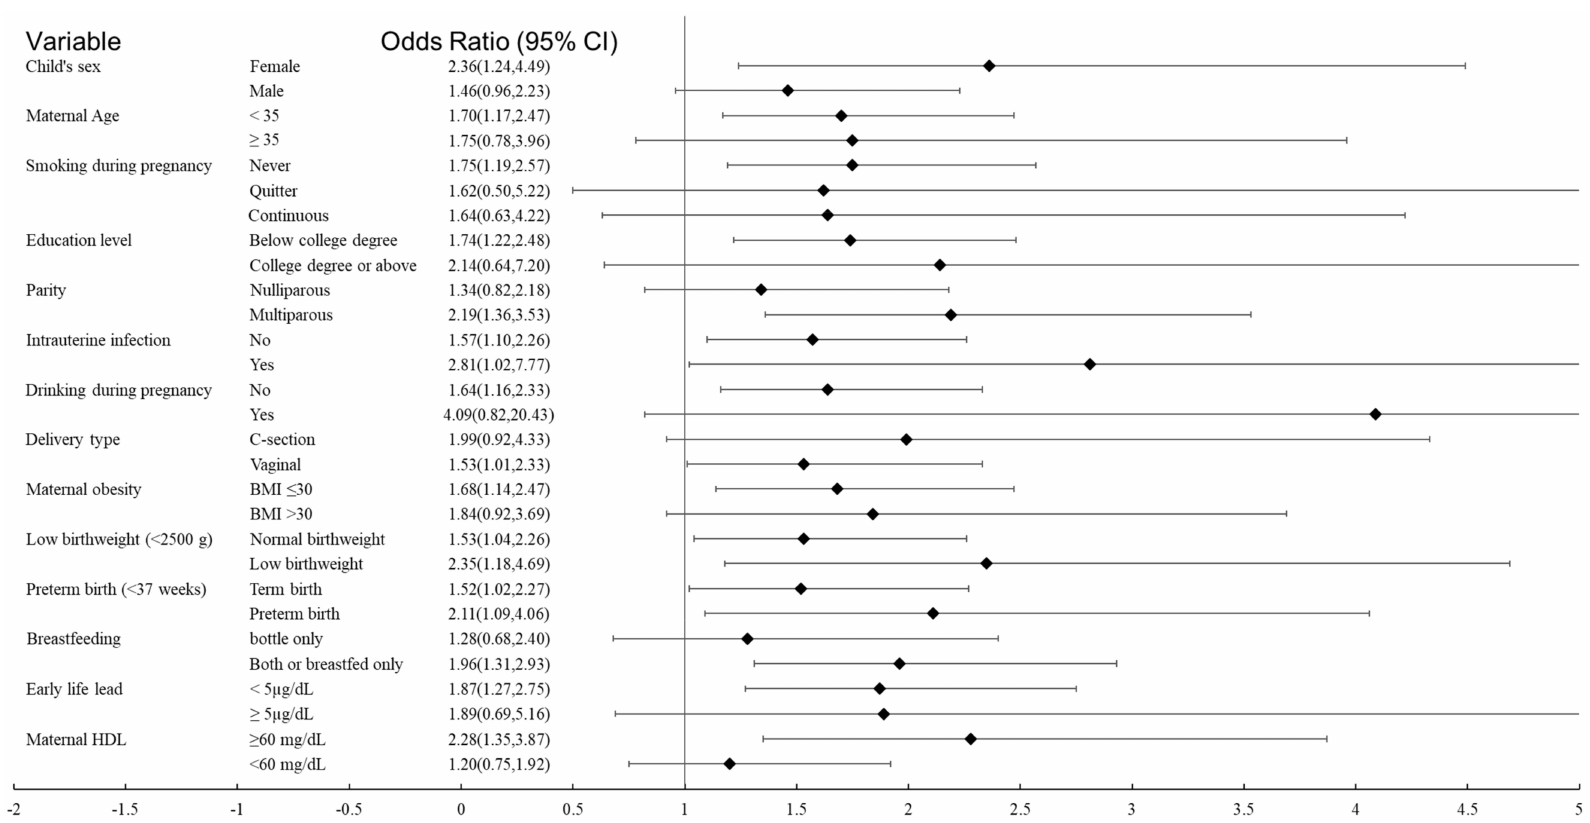
Figure 3. The forest plot for the crude association between maternal binary acetaminophen burden and the risk of ADHD diagnosis in offspring across each stratum of pertinent covariables. Acetaminophen burden is the sum of all the acetaminophen metabolites. No detection group is the reference